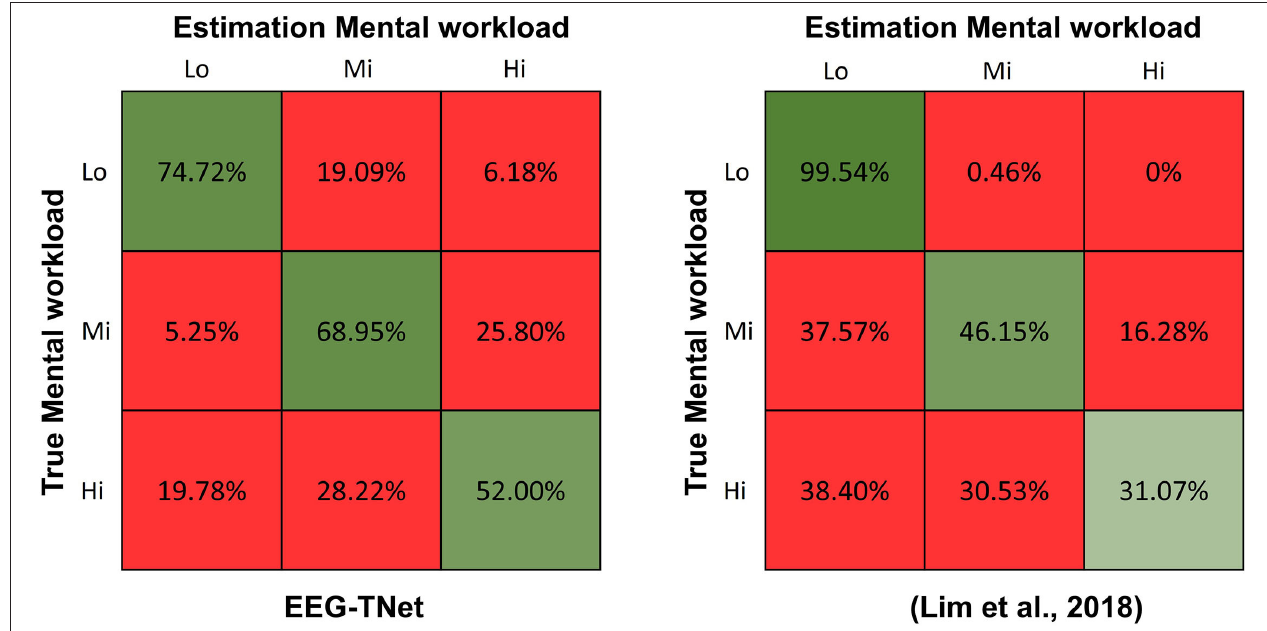
FIGURE 4 | Confusion matrix of EEG-TNet and Lim’s